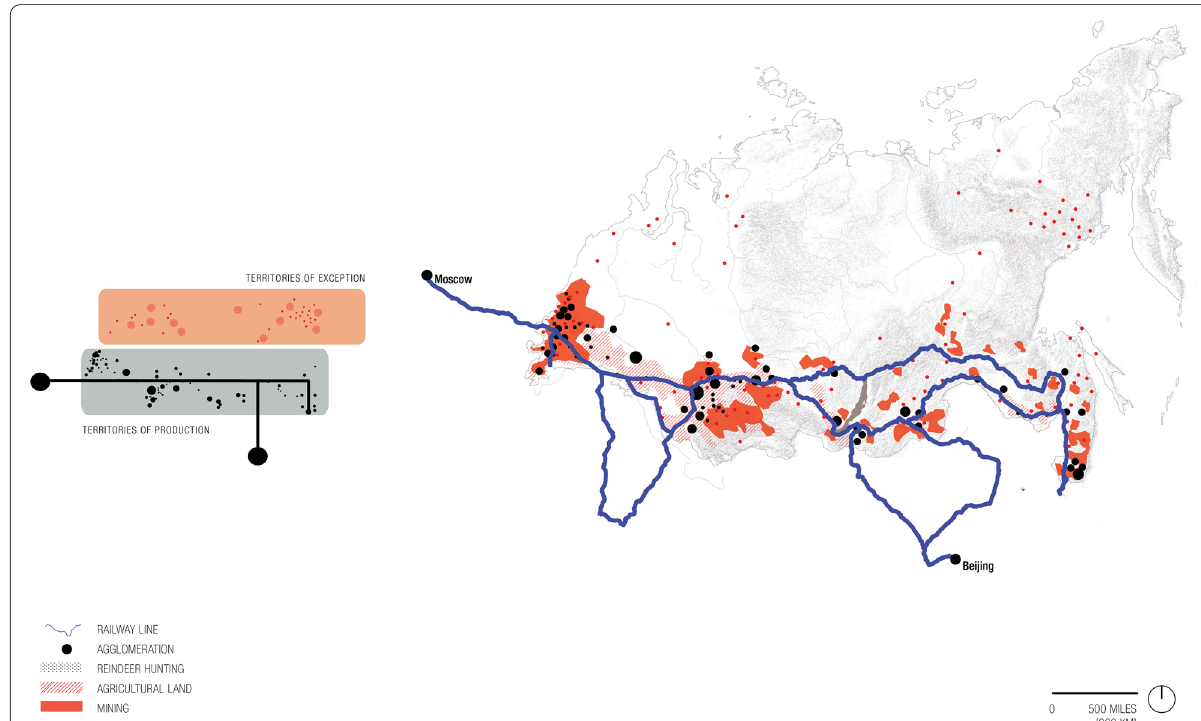
Fig. 2 Siberia: Second spatial regime. The development along the Trans-Siberian railroad includes infrastructures, settlements and areas of production, while the remote North of Siberia is treated as an area of exception. Image credits: Salgueiro Barrio and O’Shea. Image Sources: Drawing 2:Cities: ESRI, Naumov, Wikipedia, Google Maps. Transportation networks: ESRI.Mining and oil:Brown, TJ, RA Shaw, T Bide, et al. “World Mineral Production”. British Geological Survey 2013. Keyworth, Nottingham. WebCoburn, Leonard L. “Russian oil- A long term view” International Agency for Energy Economic. Working paper series. (2010). Web. (https:// www. iaee. org/ en/ publi catio ns/ newsl etter dl. aspx? id 105)Grama, Yulia. “The Analysis = of Russian Oil and Gas Reserves”. International Journal of Energy Economics and Policy. Vol. 2, No. 2 (2012) pp.82-91. Web. (http:// www. google. com/ url? sa t& rct j&q & esrc s& frm 1& source web& cd 1& sqi 2& ved 0CDEQ FjAA& url http% 3A% 2F% 2Fwww. econj ourna ls. com% 2Find ex. php% = = = = = = = = = = 2Fije ep% 2Fart icle% 2Fdow nload% 2F185% 2F104 & ei DjWMU aH6GJ bJ4AO G0IDA Dg& usg AFQjC NF2MUx_ VCUve kHTS2 yEsuJ 3K8n4 Pw& sig2 = = = L5eDY FZJ6U o3u3H Tpz5a Gg& bvm bv. 46340 616,d. dmg). Agriculture: Shotskii, V. P. (Vladimir Porfir ʹ evich). Agro-Industrial Complexes and Types of = Agriculture in Eastern Siberia. 8 Vol. Budapest: Akadémiai Kiadó, 1979.